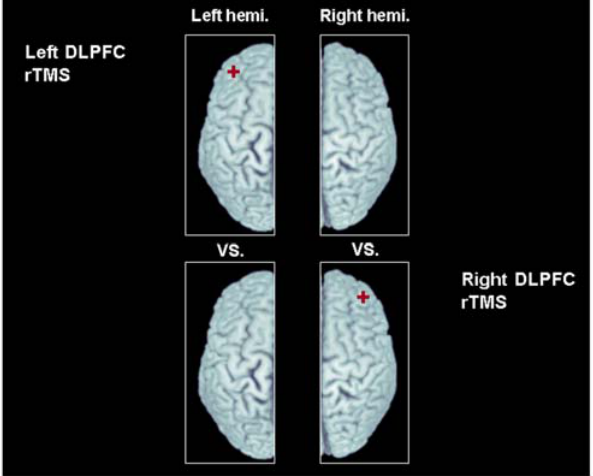
Figure 4. Contrast analysis for each stimulation conditions: changes in [11C]FLB 457 BP of the stimulated hemisphere were tested against [11C]FLB 457 BP of the ipsilateral (non- stimulated) hemisphere of the other session (control). Red mark indicate stimulation site.